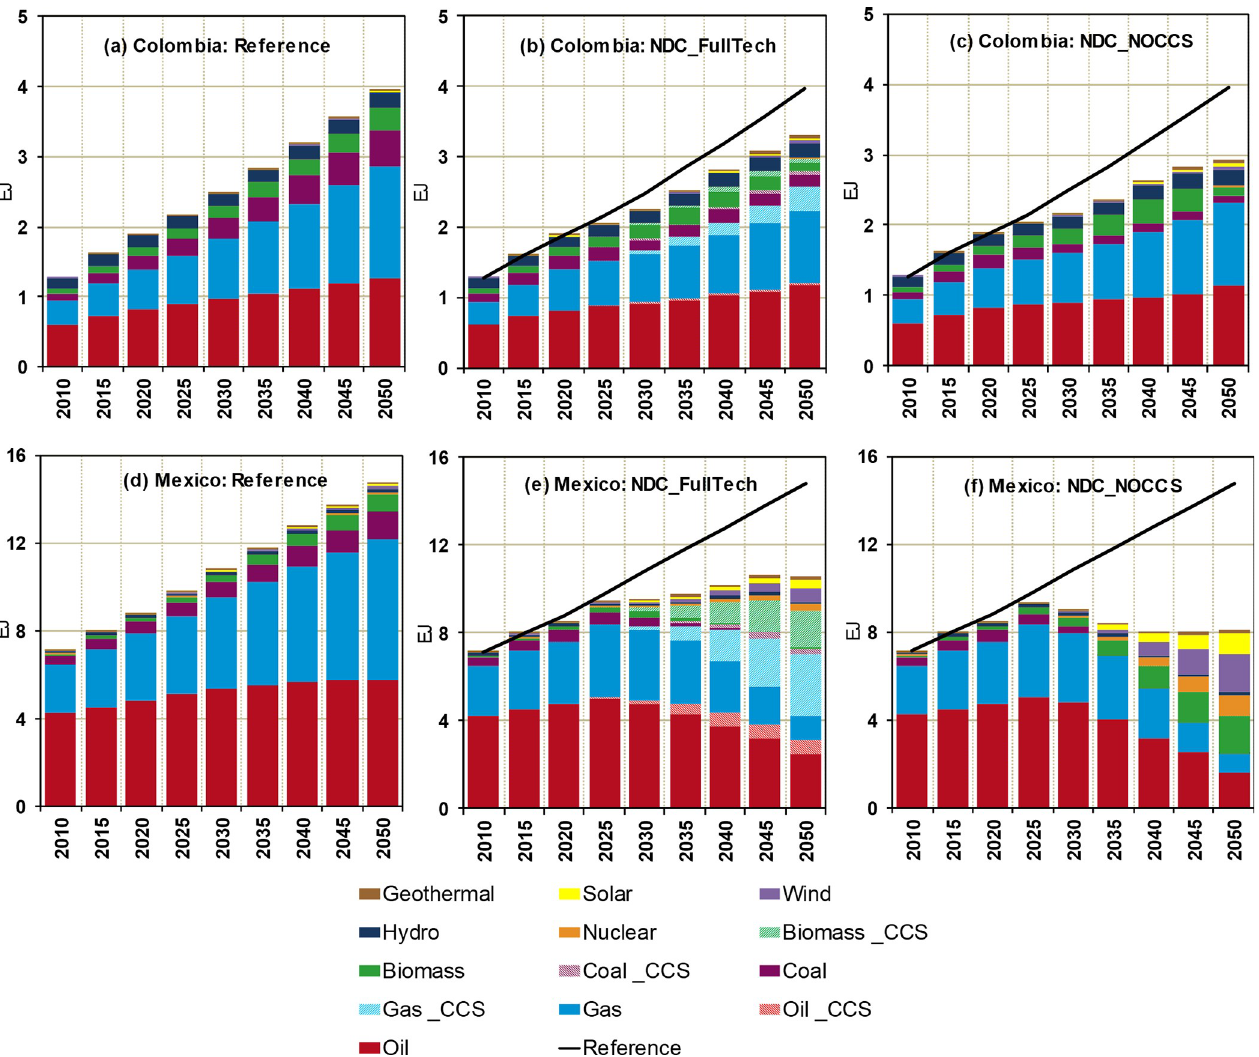
Fig 2. Distribution of the primary energy consumption (EJ) for the Reference ((A) and (D)), NDC_FullTech ((B) and (E)) and NDC_NOCCS ((C) and (F)) scenarios in Colombia, and Mexico,